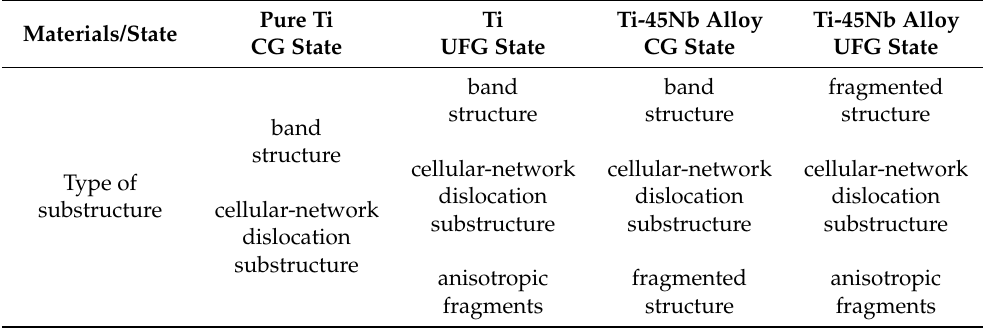
Table 3. Types of substructures formed under uniaxial tension in the pure titanium and Ti-45Nb alloy in the CG and UFG